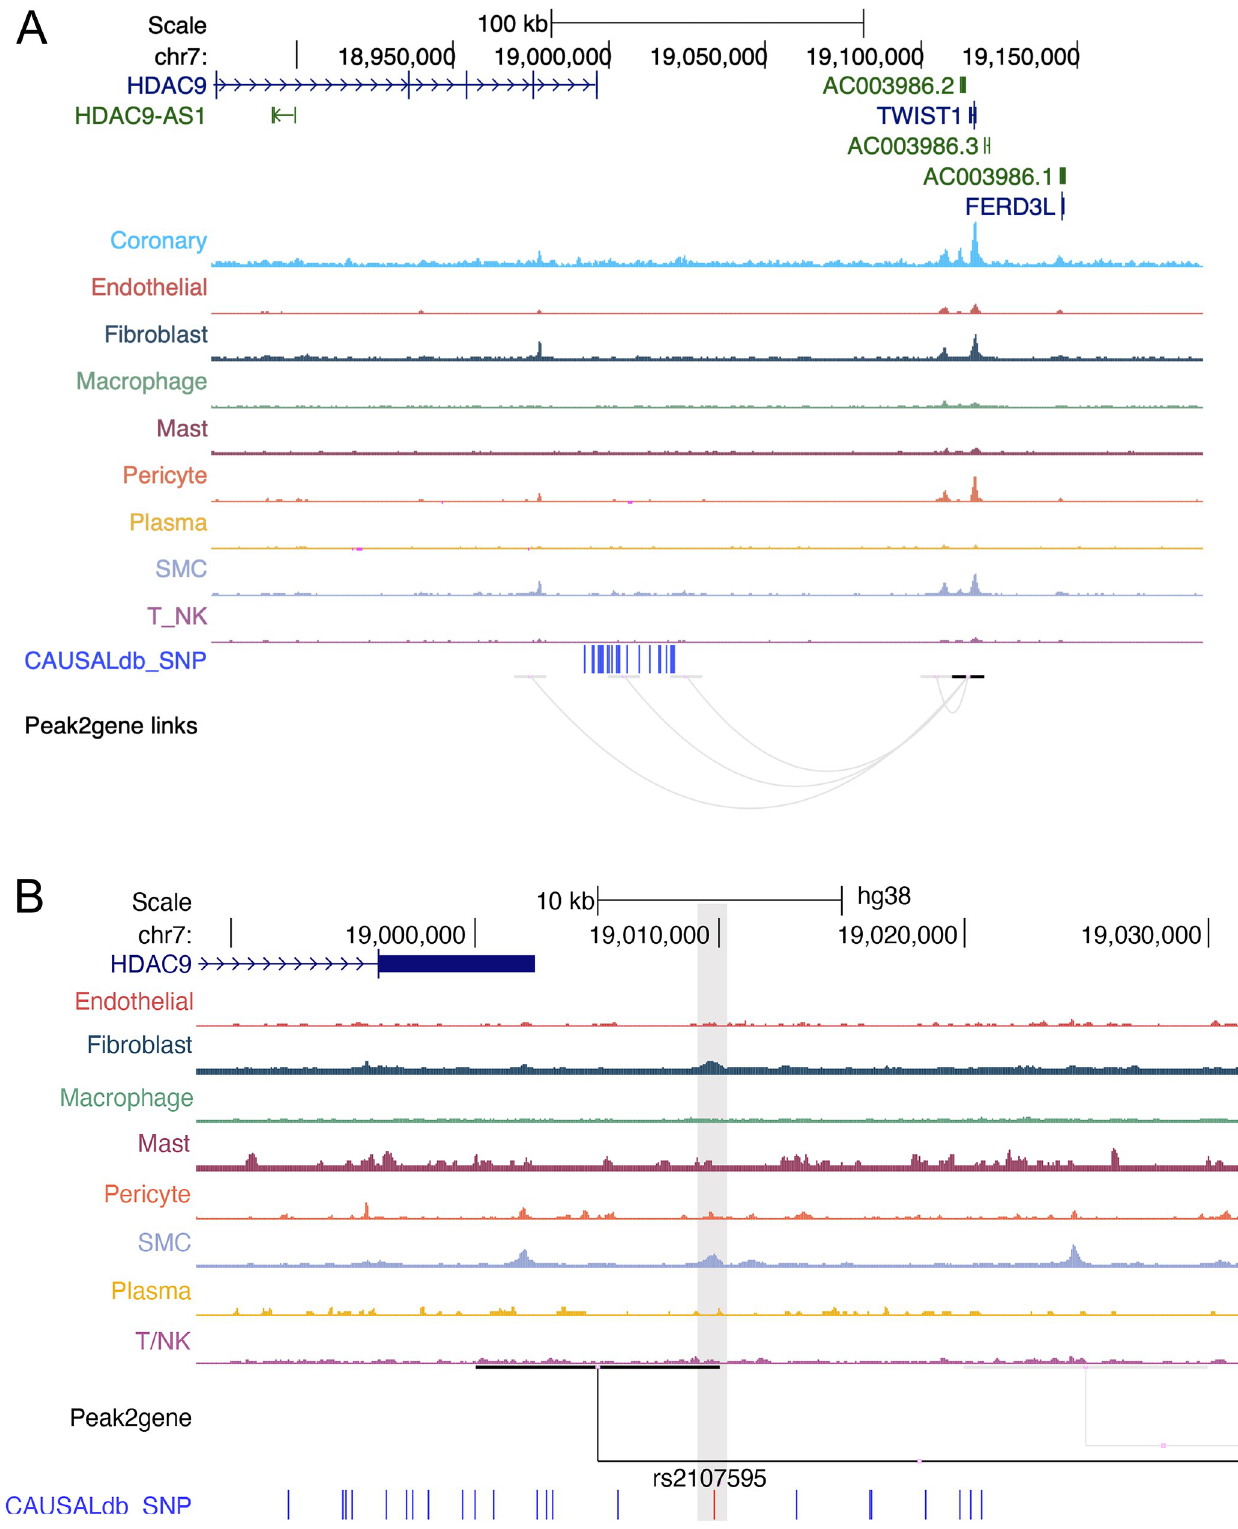
Fig 6. rs2107595 links to TWIST1 via cis-regulatory element in coronary artery cell types. Genome browser showing single-cell chromatin accessibility (scATAC-seq) profiles in human coronary artery cell types shown (A) across the wider HDAC9 -associated CAD risk locus (hg38) and (B) a zoomed in